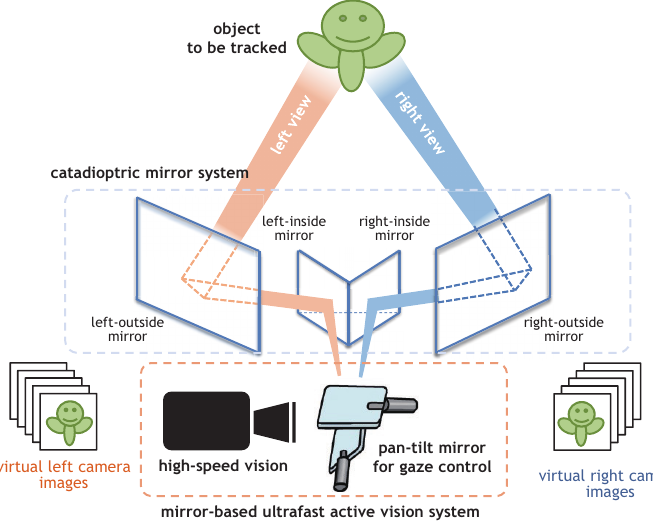
Figure 1. Catadioptric stereo tracking with multithread gaze